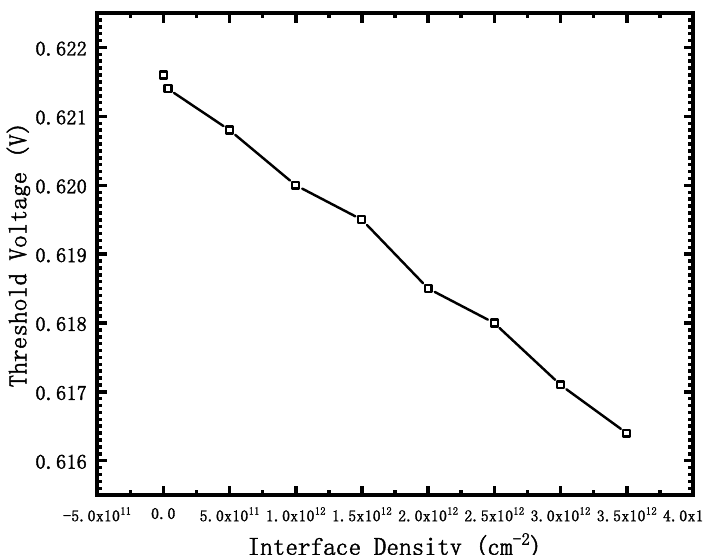
Figure 6. Threshold with different interface density.